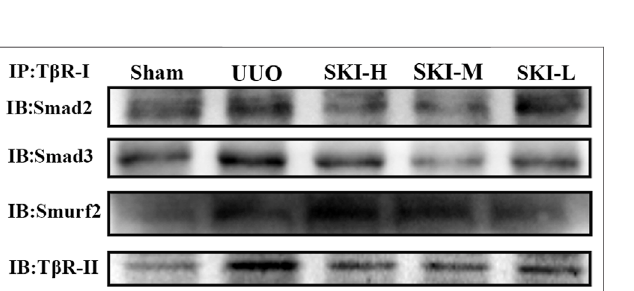
FIGURE 6 | Effect of Shenkang injection on mRNA of TGF- β /Smads signaling pathway. The mRNA expressions of TGF- β 1, T β R-I, T β R-II, Smad7, Smurf1, and Smurf2 in renal tissues were detected by RT-PCR.